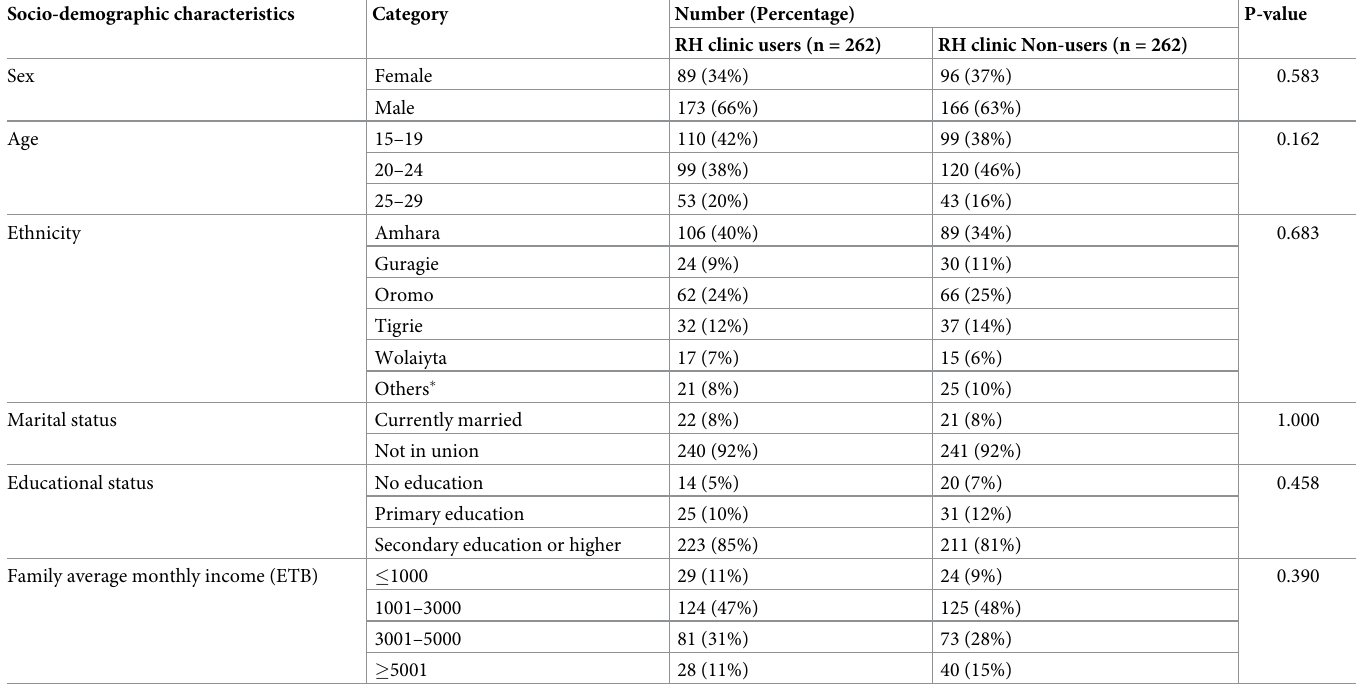
Table 1. Socio-demographic characteristics of youth by their RH clinic utilization status in Addis Ababa, Ethiopia, 2016. Socio-demographic